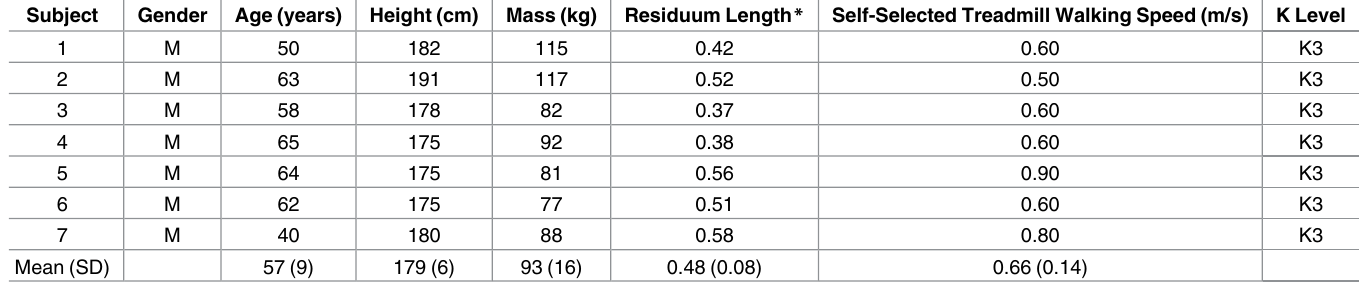
Table 1. Demographic data of subjects with unilateral transtibial